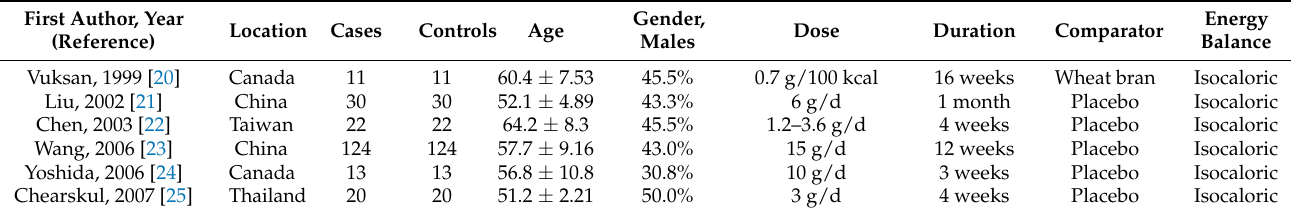
Table 1. Characteristics of the Included